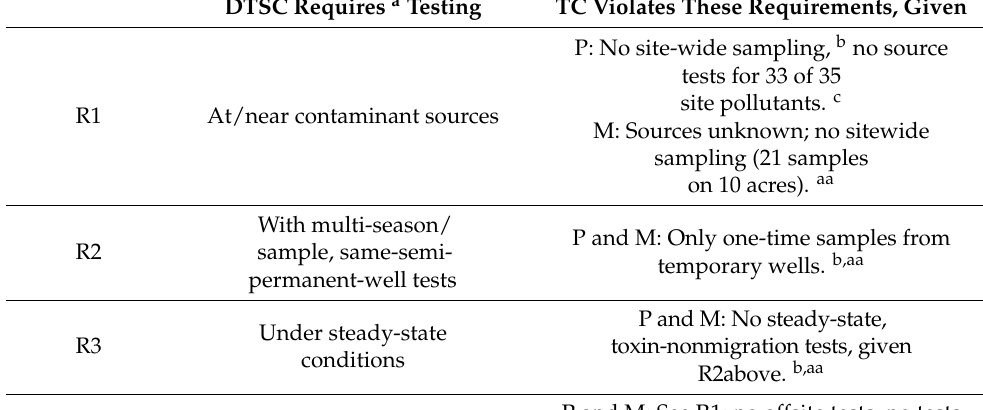
Table 3. Soil-gas-VOC-testing violations at the former NOTSPA, Pasadena, California (P) and the former heavy-manufacturing site, Monrovia, California (M).